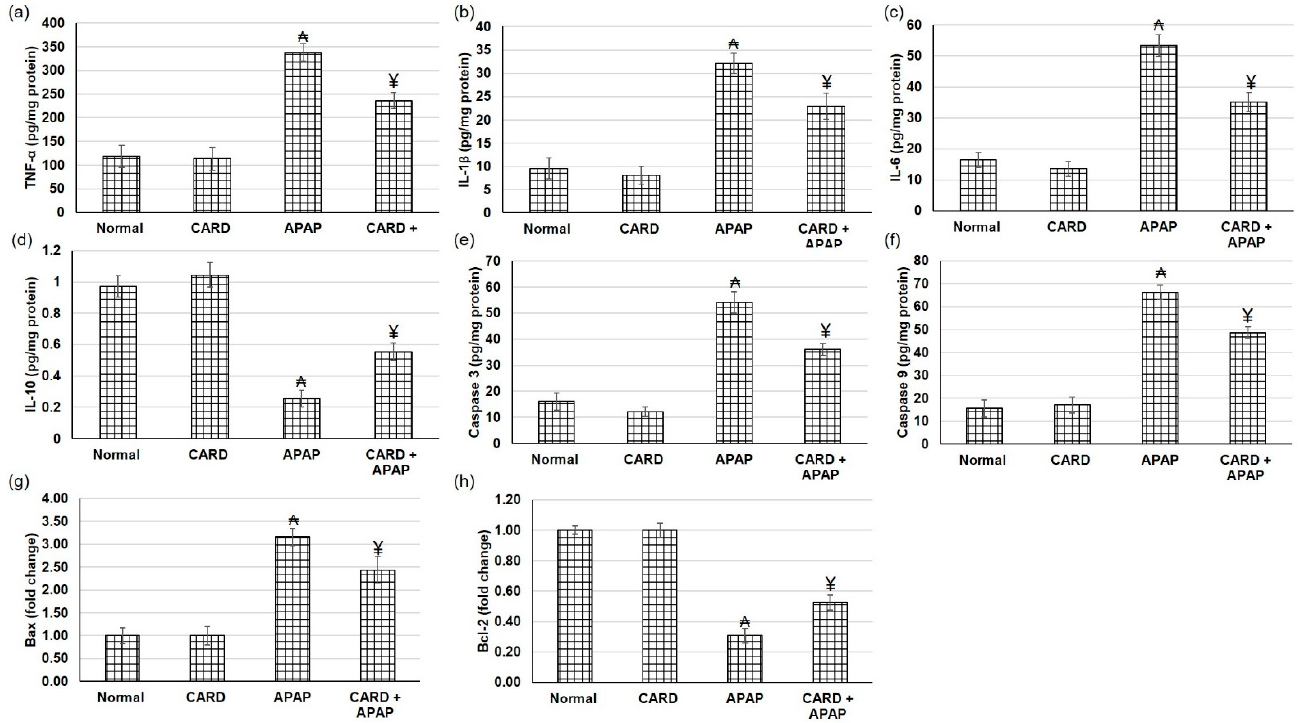
Figure 6. Effects of CARD aqueous extract (200 mg/kg) administration for 15 days prior to APAP administration (300 mg/kg) on the levels of ( a ) TNF- α , ( b ) IL-1 β , ( c ) IL-6, ( d ) IL-10, ( e ) caspase 3, ( f ) caspase 9 and gene expression of ( g ) Bax, and ( h ) Bcl2, respectively, in APAP-induced acute hepatic failure in mice. All values are stated as mean ± SD. ₳ designates statistically significant compared to the normal group and ¥ designates statistically significant compared to the APAP group ( p < 0.05) using one-way ANOVA followed by Tukey’s post hoc test.